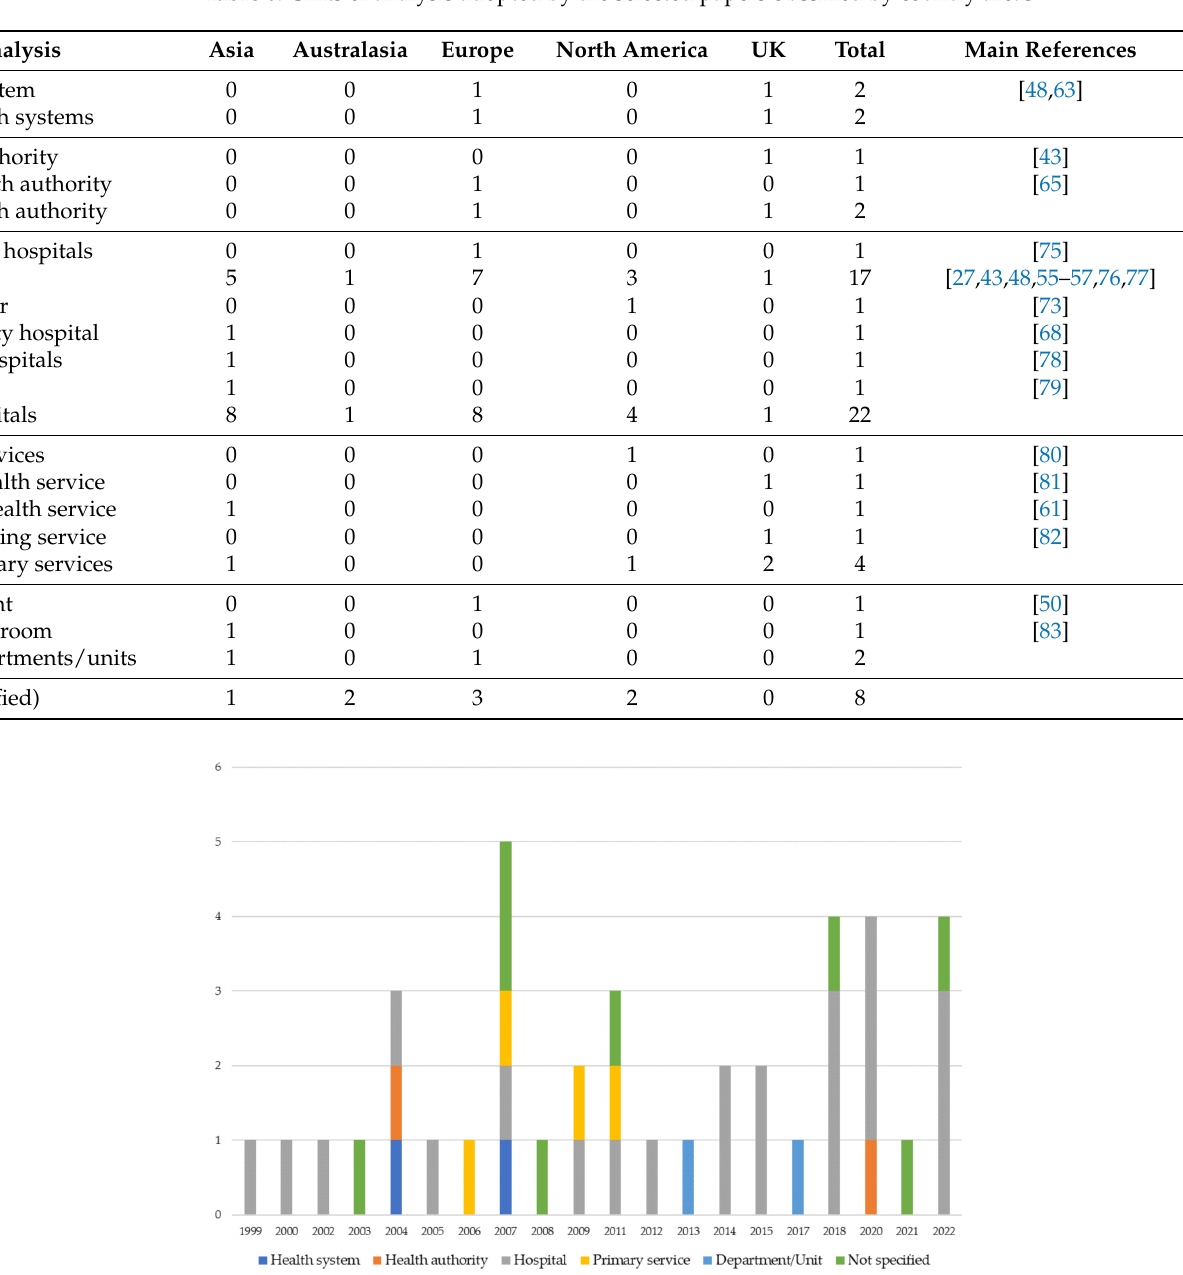
Table 6. Units of analysis adopted by the selected papers classified by country areas.